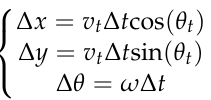
Figure 2. Schematic diagram of the USV kinematic model.